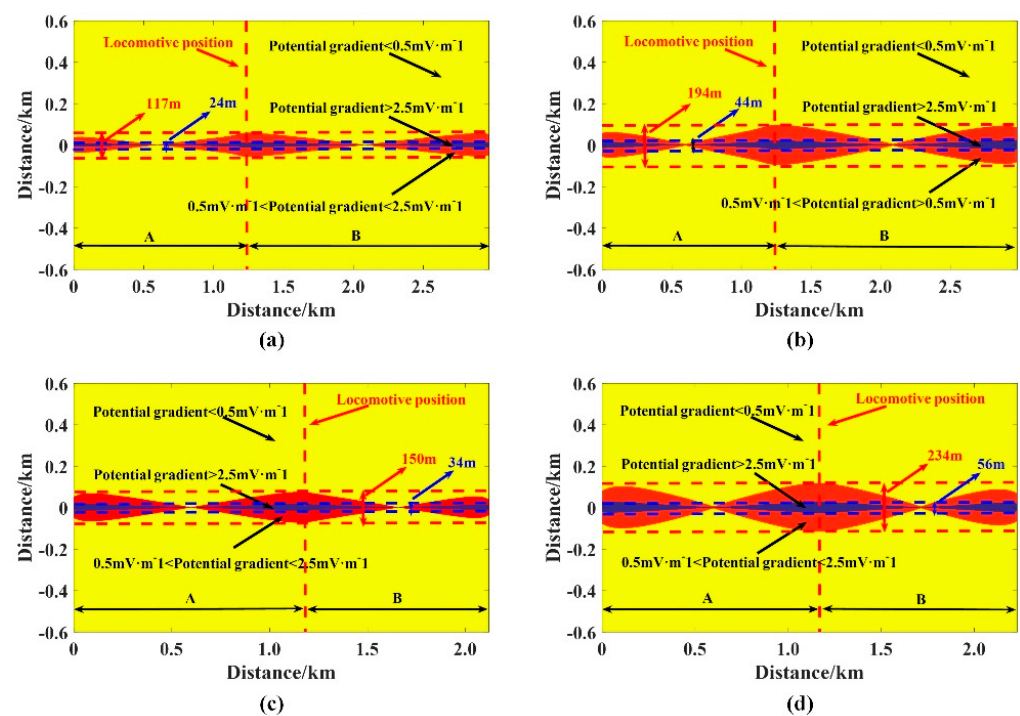
Figure 14. Stray current corrosion scope: ( a ) Interval I; ( b ) Interval II; ( c ) Interval III; ( d ) Interval IV.